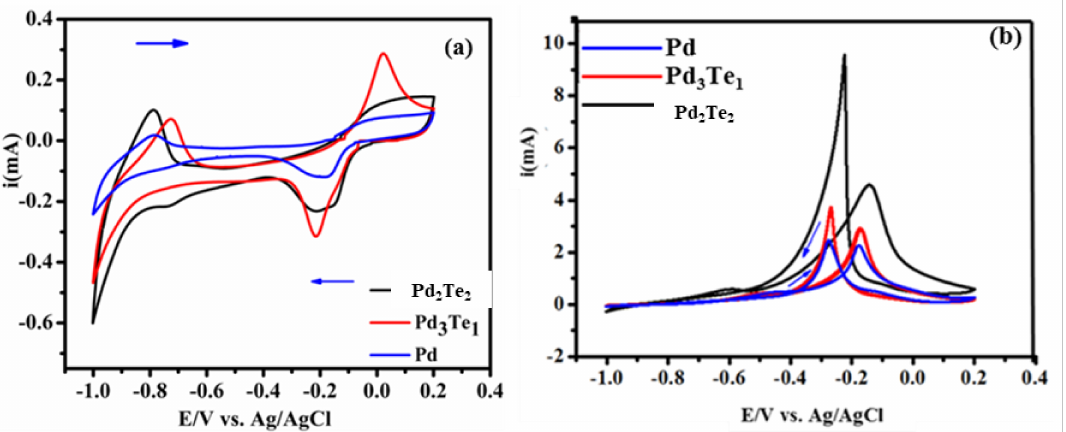
Figure 4. ( a ) CVs recorded for the Pd-based electrode catalysts in a solution of ( a ) 0.5 M KOH and